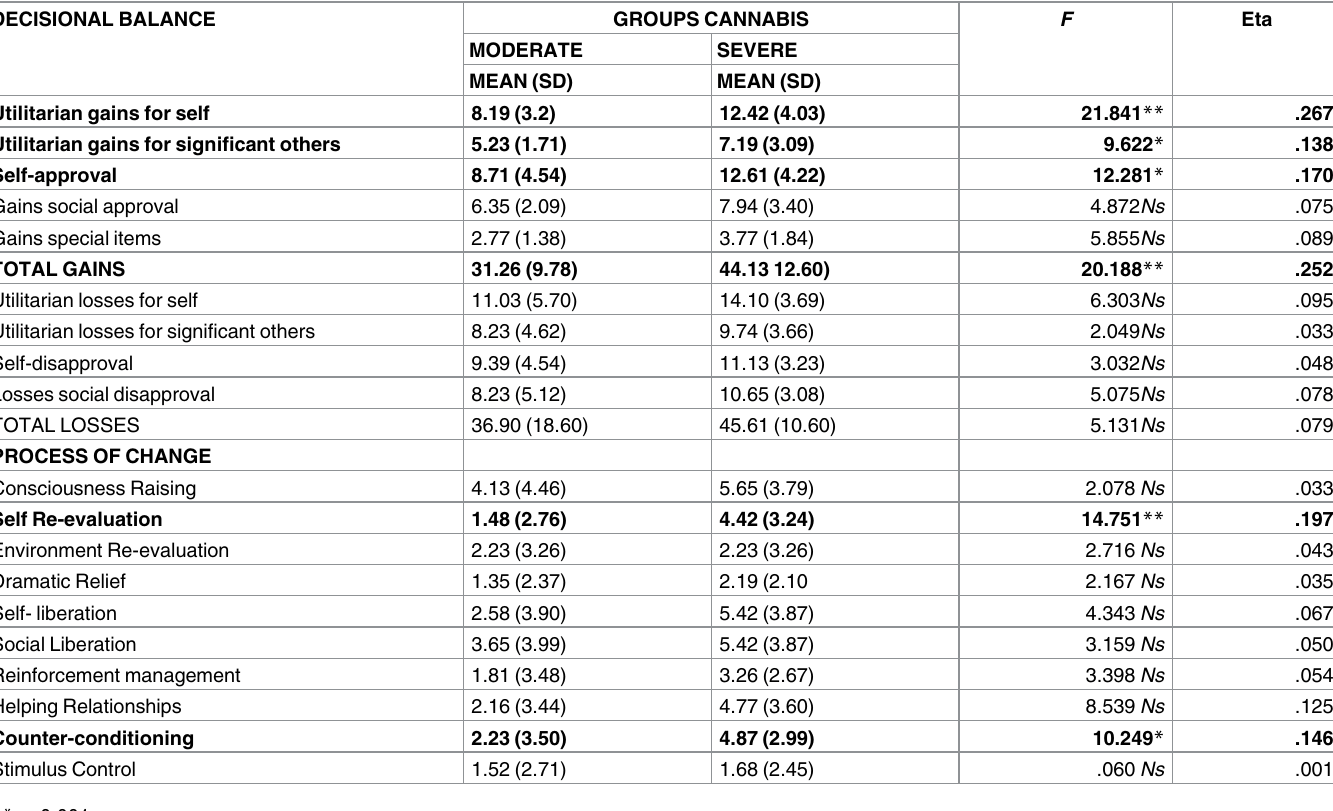
Table 2. Mean and typical deviation to evaluate status cannabis abuse decisional balance and process of